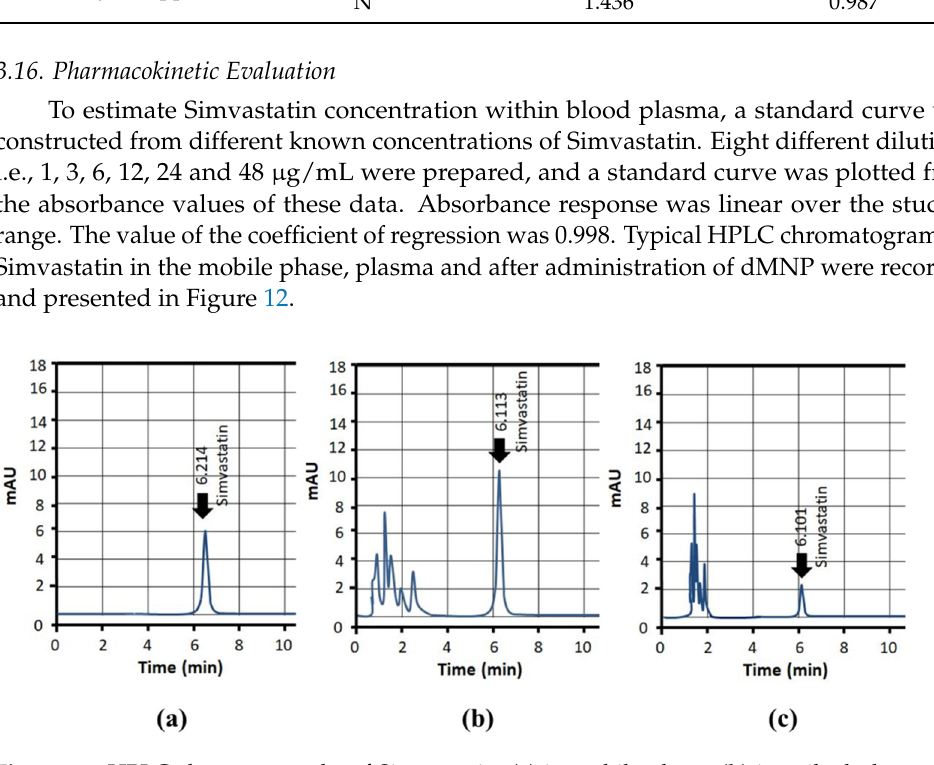
Figure 12. HPLC chromatographs of Simvastatin, ( a ) in mobile phase, ( b ) in spiked plasma and ( c ) after application of dMNP.